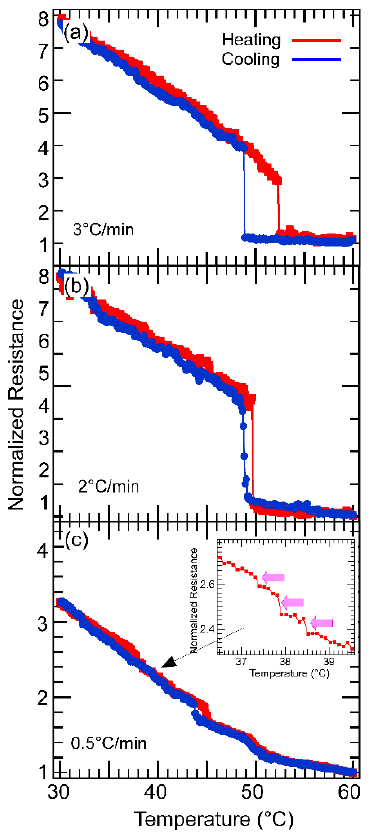
Figure 6. Normalized R - T curves for the VO 2 wire with 20 nm-gap-electrodes measured at temperature-sweep-rates of ( a ) 3 °C/min, ( b ) 2 °C/min, and ( c ) 0.5 °C/min. Magnified step changes (indicated by arrows) are shown in the insets of ( c ).